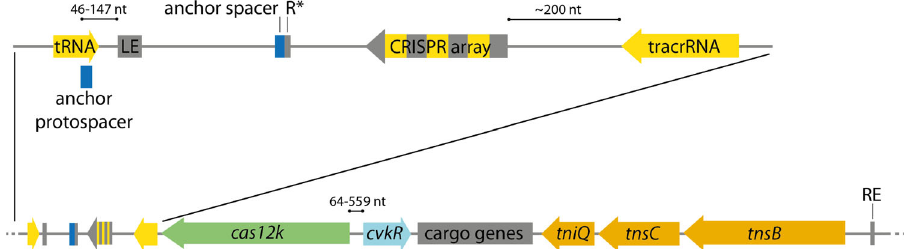
Fig. 1 | Principal gene arrangement within cyanobacterial CAST systems. The CAST transposon isdisplayed from its leftend (LE) to its right end (RE). The genes are colored according to function (green: cas12k , orange: transposase genes, light blue: CAST regulator gene ( cvkR in Anabaena 7120), yellow: regions from which non-codingRNAistranscribed,darkgray:cargogenes).Ontop,theregionfromthe